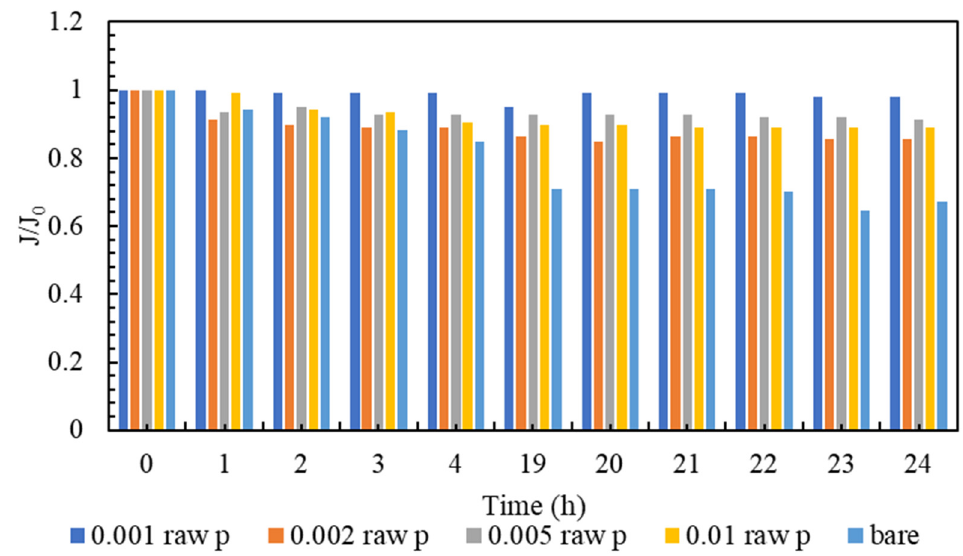
Figure 8. A comparison of Normalized flux (J/J0) of the modified membranes to the bare one.